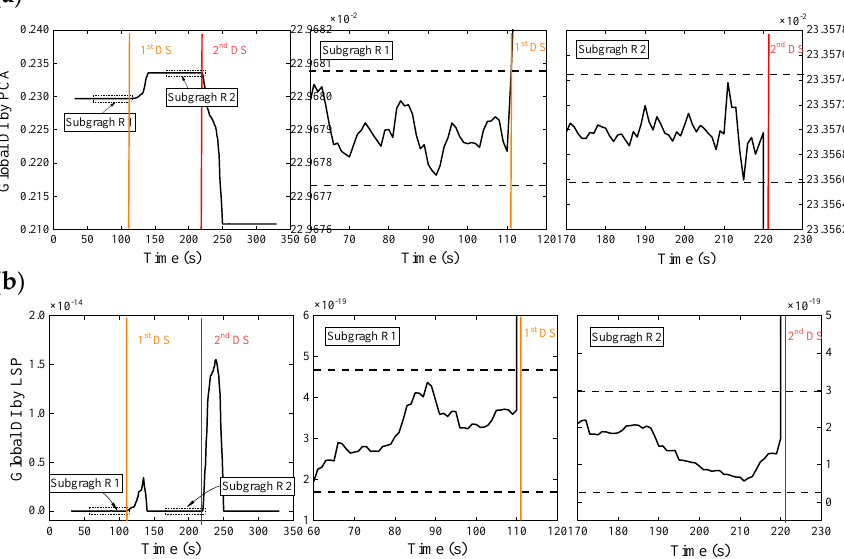
Table 2. Performance of damage detection with missing data (MD) and limited measurement (LM) cases using the WPES-based PCA and LSP methods.